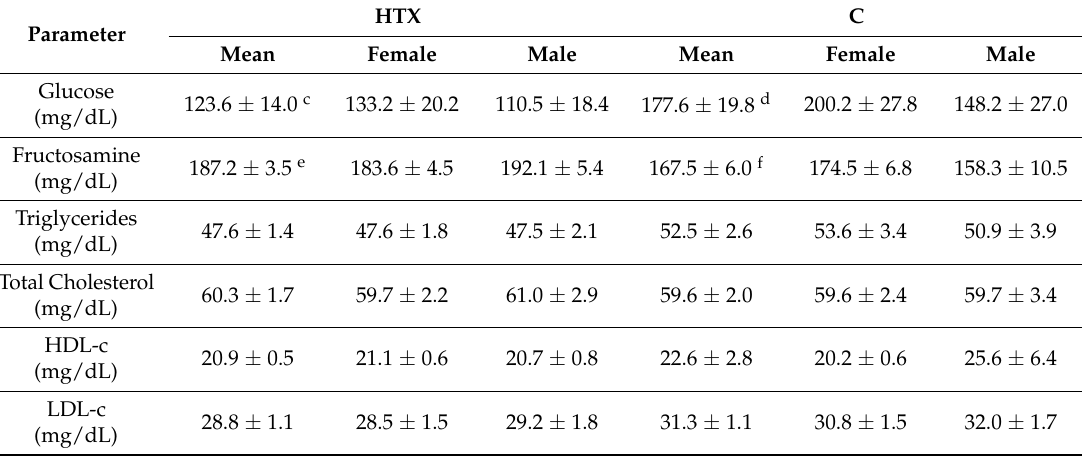
Table 5. Fetal metabolic status at day of sampling (Day 100 of pregnancy). Mean values ( ± SEM) and differences for sexes in treated (Hydroxytyrosol; Group HTX) and control fetuses (Group C). HDL-c for high-density lipoproteins cholesterol and LDL-c for low-density lipoproteins cholesterol). Superscript letters indicate significant differences between groups: a (cid:54) = b: p < 0.9, c (cid:54) = d: p < 0.05, e (cid:54) = f: p < 0.01, g (cid:54) = h: p <